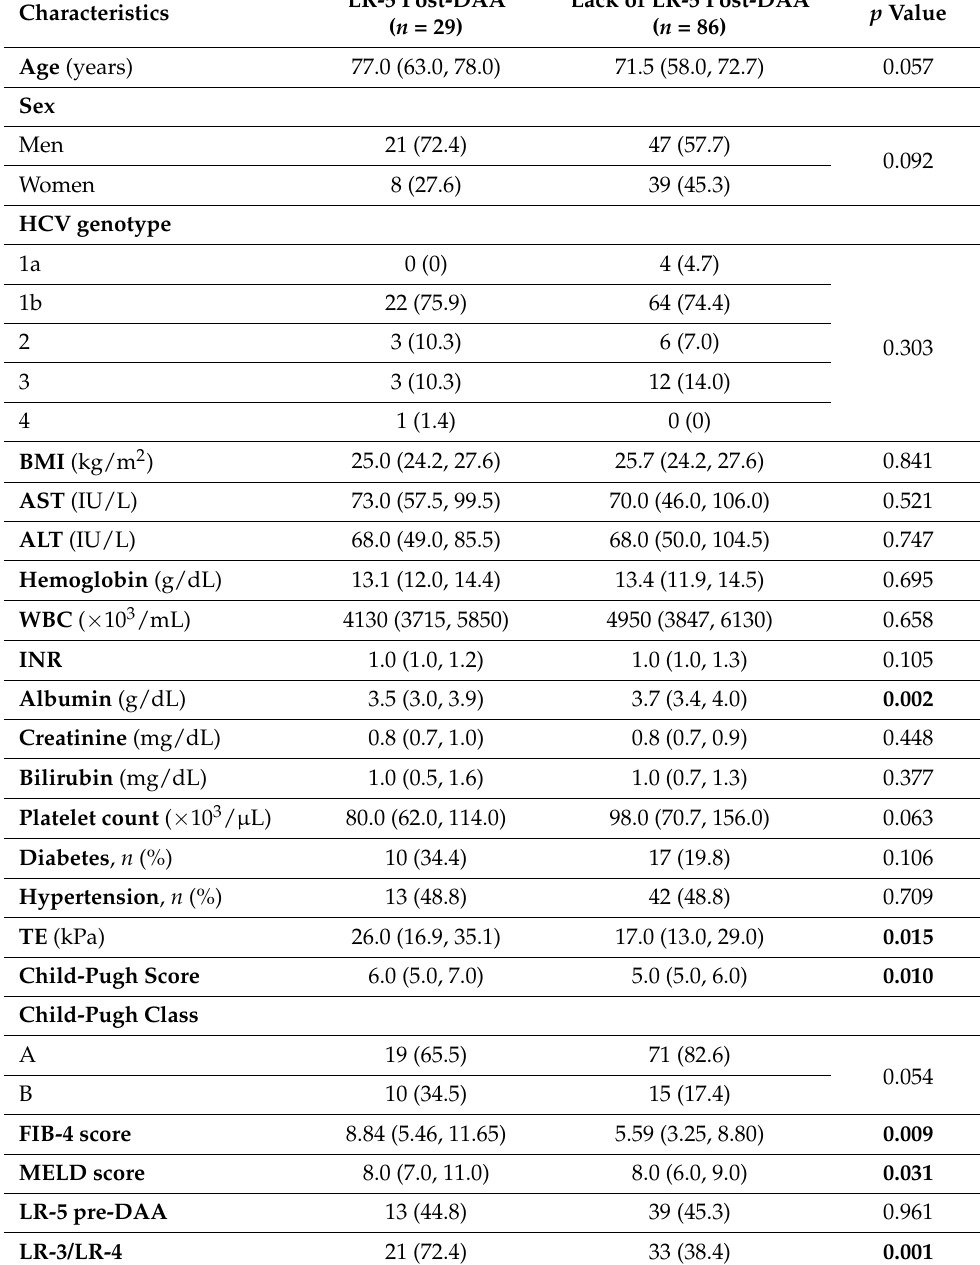
Table 2. Characteristics of the patients with LR-5 occurrence after direct acting